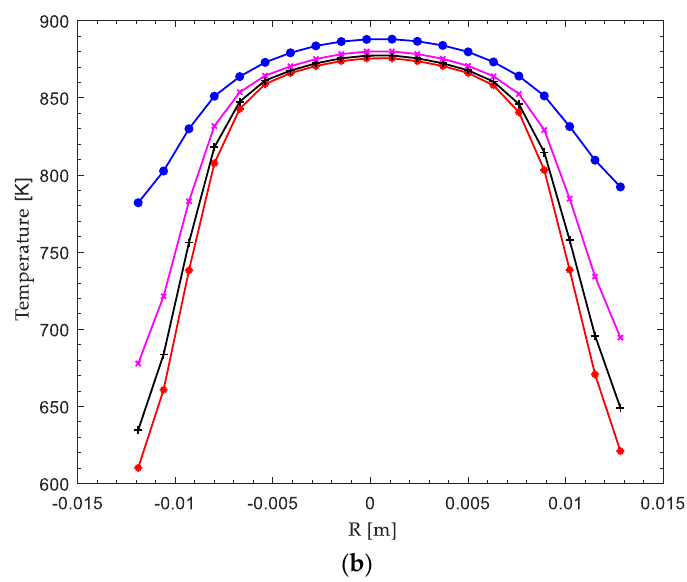
Figure 6. ( a ) Effect of thermal oil feed rate on the axial temperature profile, at representative tube centerline (1-m reactor module). ( b ) Effect of thermal oil feed rate on the radial temperature profile at hot-spot (1-m reactor module).